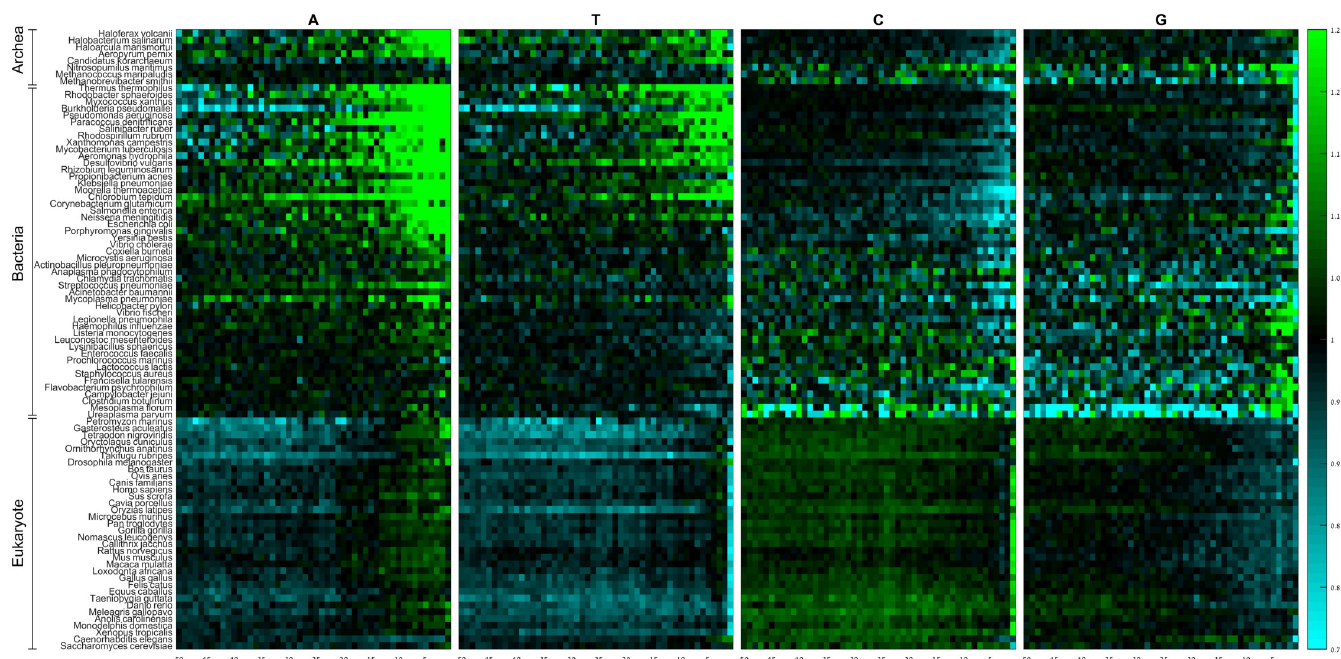
Fig 2. Group RSCA scores of A-ending, T-ending, C-ending, and G-ending codons along the last 50 codons of the gene. Rows denote species, columns denote positions. Species within domains are sorted from high (top) to low (bottom) GC-content.